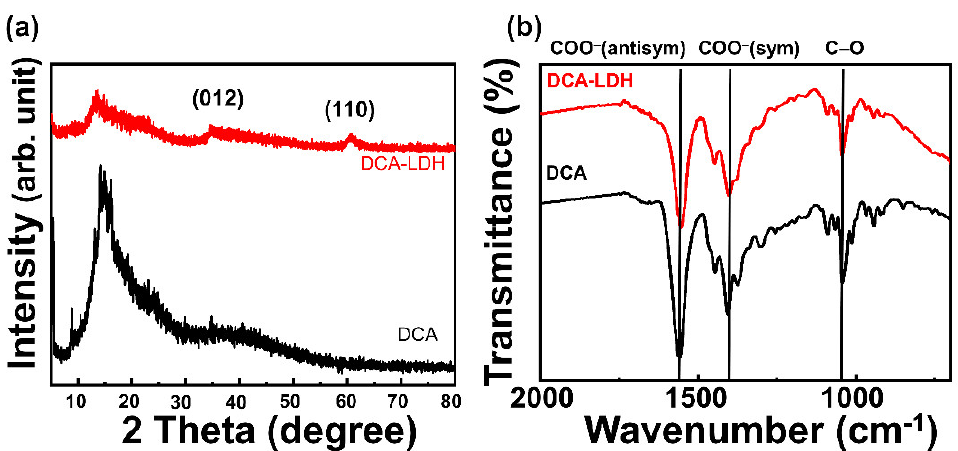
Figure 2. ( a ) X-ray diffraction pattern, and ( b ) FT−IR for DCA and DCA−LDH.